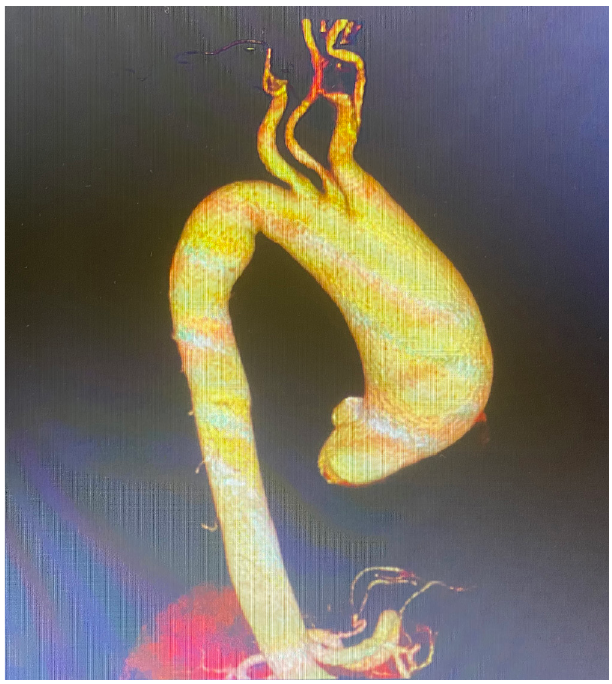
Fig. 1 - Preoperative 3D computed tomography image of a patient with ascending and aortic arch